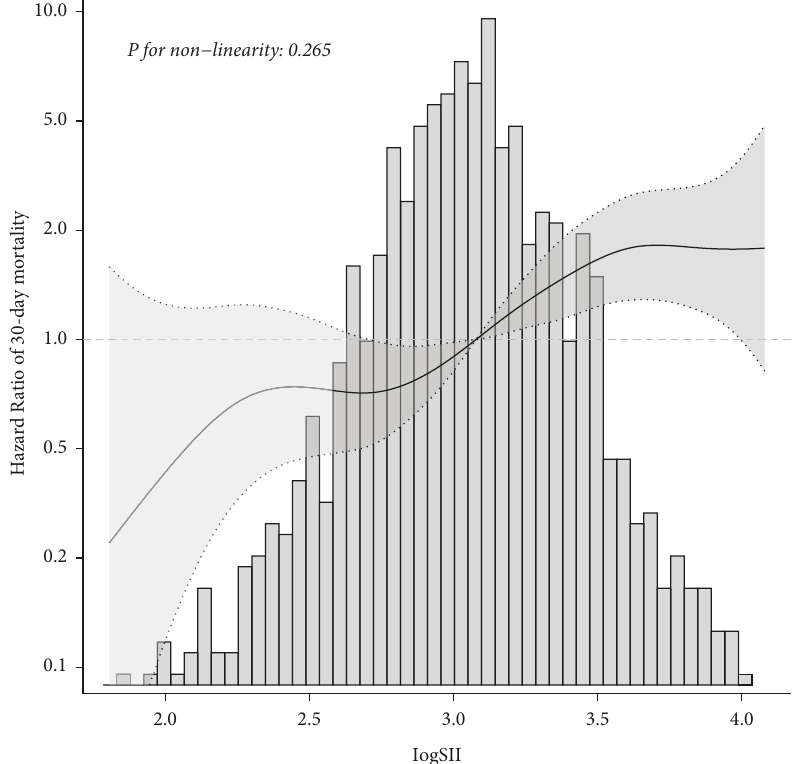
Figure 3: Smooth curve fitting for LogSII to HR of 30-day